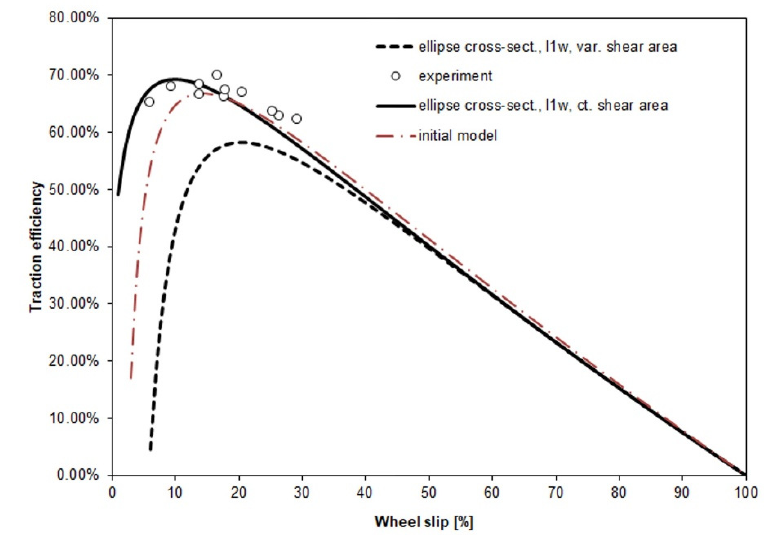
Figure 6. Traction efficiency of the 2 WD tractor with 65 HP.